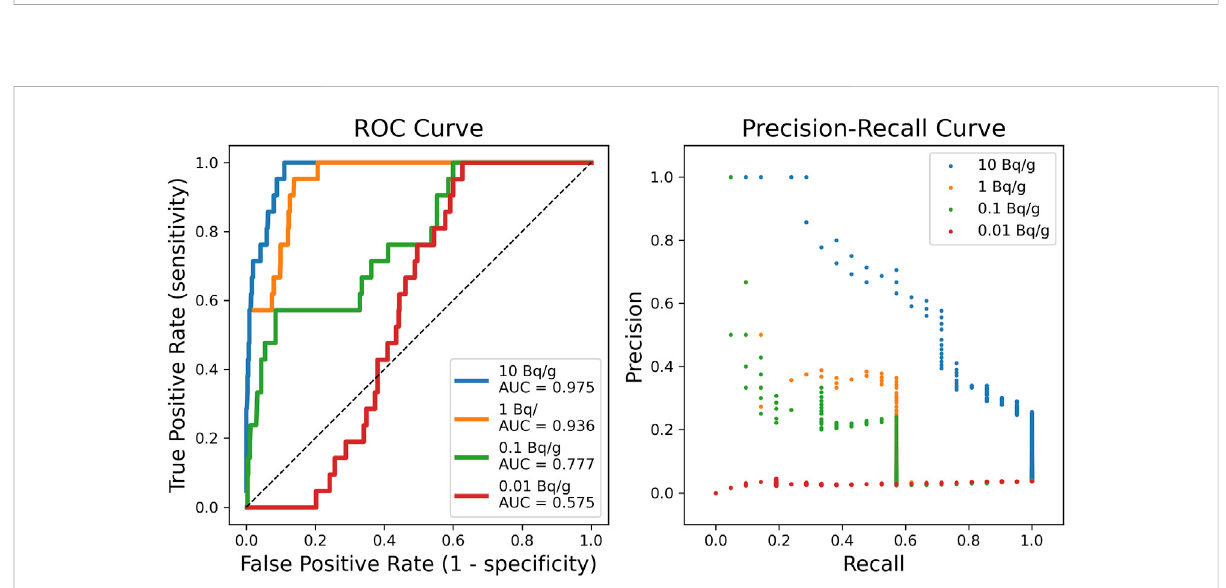
FIGURE 8 Receiver operation characteristic (ROC) curve (left) and precision – recall curve (right) with models that are trained by datasets with different